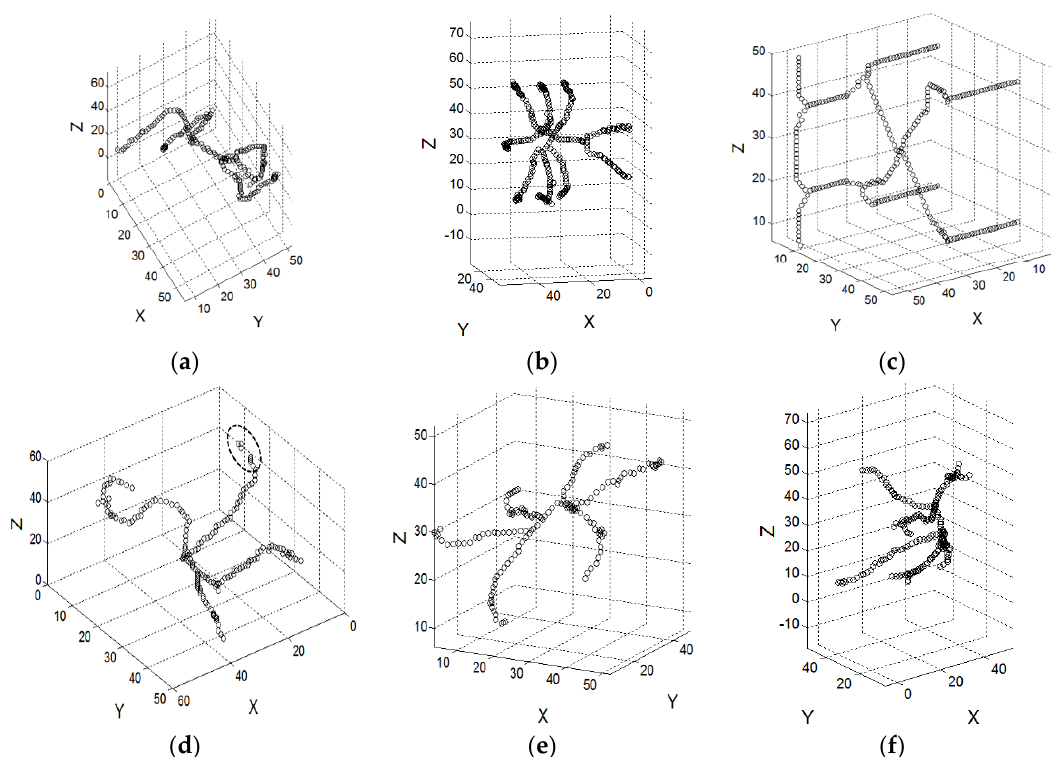
Figure 15. Skeletons extracted by the proposed method. ( a ) The skeleton of the man; ( b ) The skeleton of the ant; ( c ) The skeleton of the chair; ( d ) The skeleton of the flamingo; ( e ) The skeleton of the lion; ( f ) The skeleton of the camel.